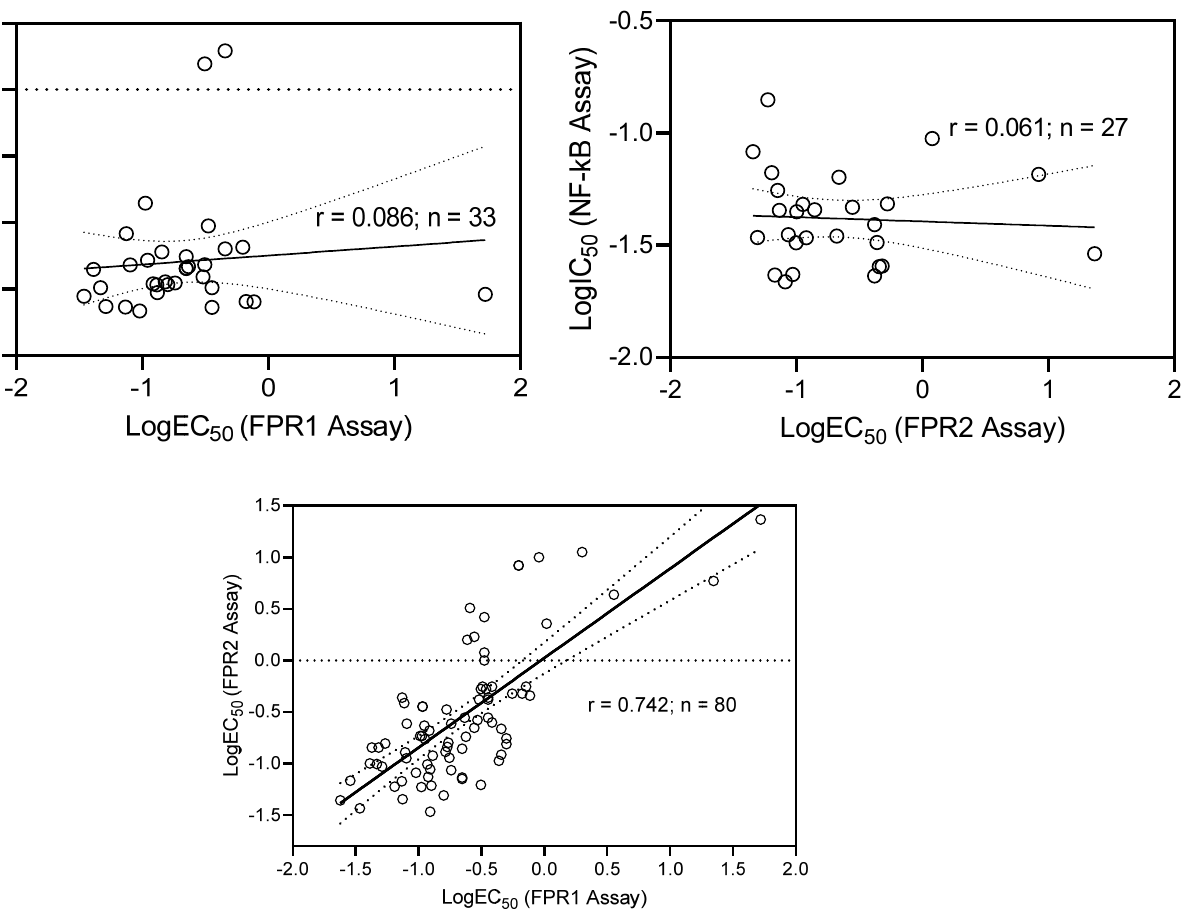
Figure 6. Correlation of NF- κ B inhibitory activity and FPR1/FPR2 agonist activity for compounds manifesting both type of activities. The activities are represented as a logarithm (logIC 50 or logEC 50 ). Among the pyridazinones and related derivatives evaluated for anti-inflammatory activity were 98 FPR1/FPR2 agonists and 79 compounds with no FPR agonist activity. Our analysis revealed that 46 of these compounds were not cytotoxic and exhibited anti-in- flammatory activity, as determined by their ability to inhibit the LPS-induced NF- κ B ac- tivity in human THP1-Blue monocytic cells. The most potent of these compounds also